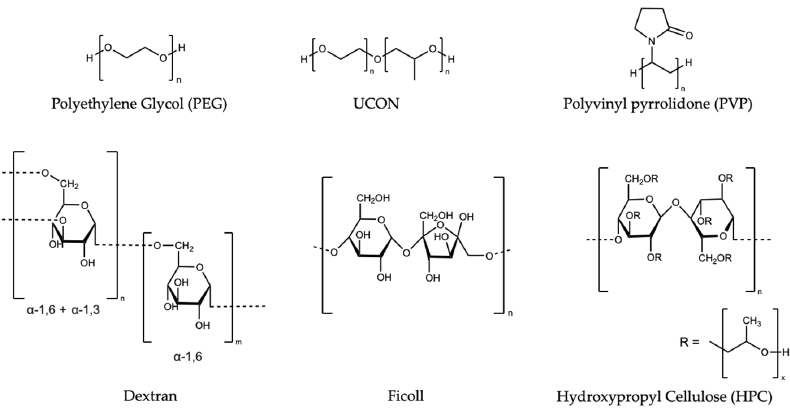
Figure 1. Structures of synthetic polymers referenced in this Review.